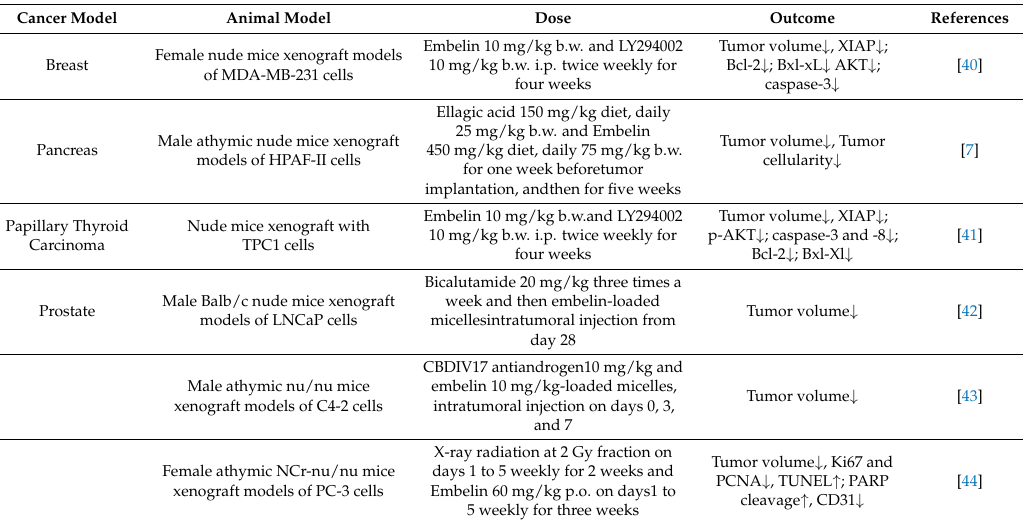
Table 2. Synergistic anti-cancer effects of embelin in